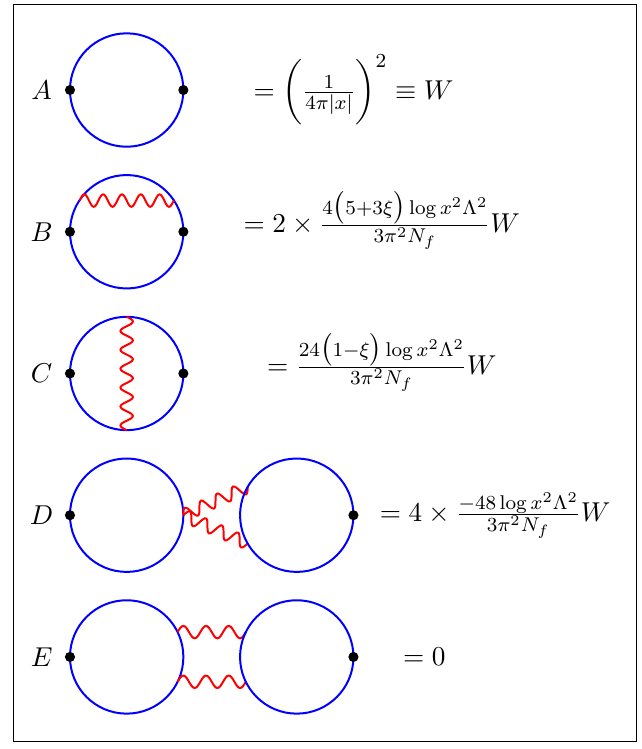
Table 2 . (bQED) Results for individual Feynman graphs appearing in the 2-point correlation function of the scalar-bilinear operators.